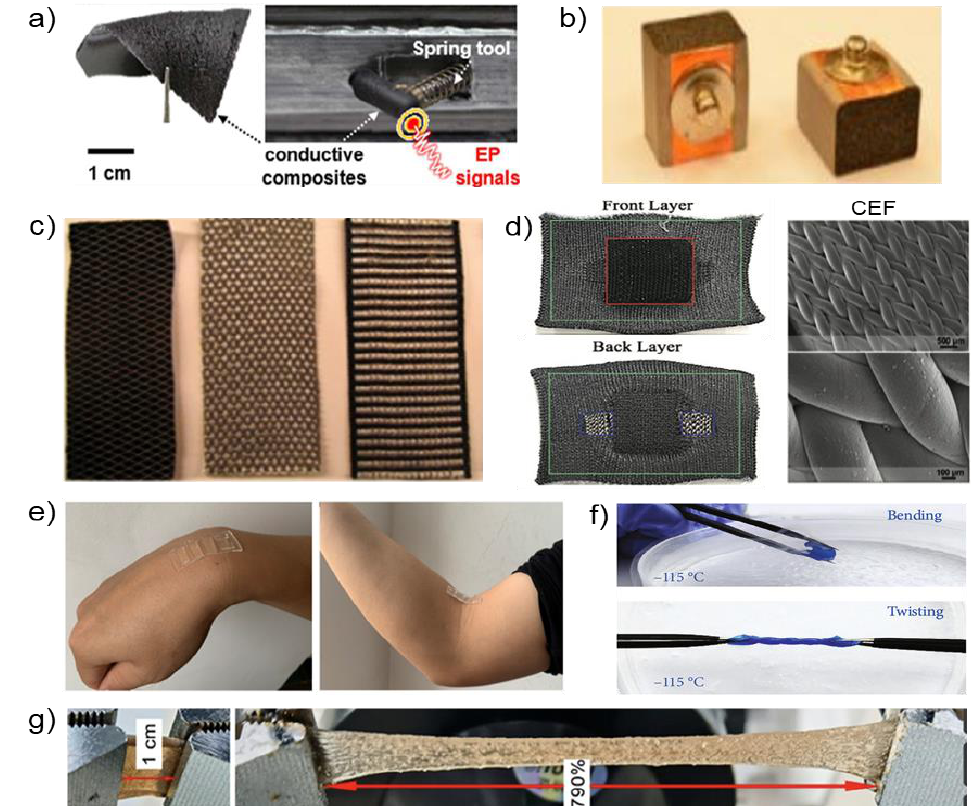
Figure 3. Examples of composite electrodes. ( a ) Carbon nanotubes embedded in a printed eyeglass (Reprinted with permission [5]. Copyright 2020 American Chemical Society). ( b ) Conductive polymer foam based on urethane and taffeta materials (Reprinted with permission under the terms of the CC-BY license [38]. Copyright 2021, the Authors. Published by MDPI). ( c ) Silver embroidered electrode and electrode-lead connection (Reprinted with permission under the terms of the CC-BY license [21]. Copyright 2021, the Authors. Published by MDPI). ( d ) 3D-Knit dry electrodes using conductive elastomeric fibers with CEF (Reprinted with permission [90]. Copyright 2022 Wiley- VCH GmbH). ( e ) Photographs demonstrating adhesion of the flexible hydrogel (Reprinted with permission under the terms of the CC-BY license [97]. Copyright 2021, the authors. Published by MDPI). ( f ) Tortuosity of the proposed hydrogel at − 115 °C (Reprinted with permission under the terms of the CC-BY license [98]. Copyright 2021, the Authors. Published by IOP). ( g ) Photographs demonstrating the stretchability of the starch hydrogel (Reprinted with permission [61].